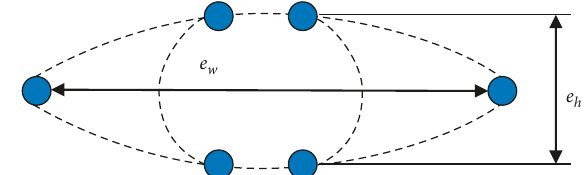
Figure 4: Diagram of the eye height-to-width